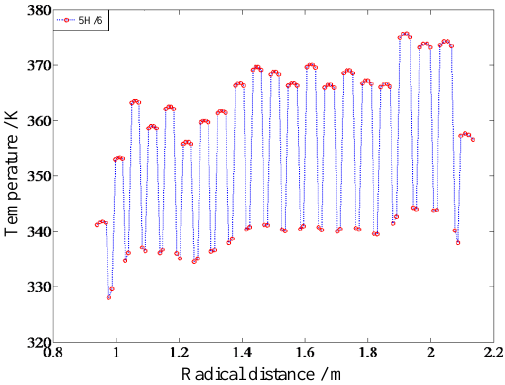
Figure 7. Radial temperature distribution at the height of 5/6H.